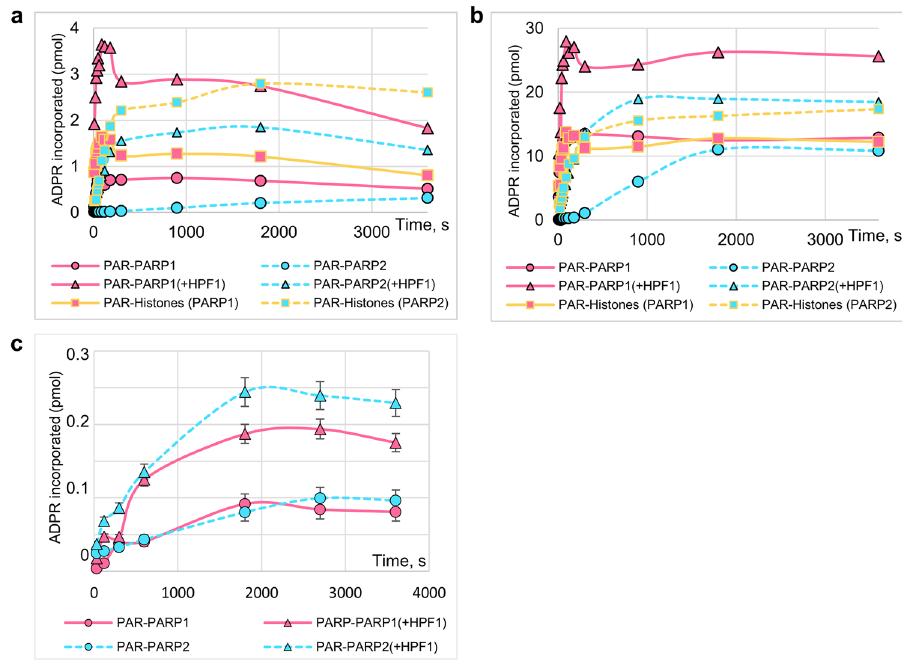
Fig. 4 HPF1 modulates the auto- and heteromodi fi cation activities of PARP1 and PARP2 at the initial stage of the reactions. Typical kinetic curves of PARP1- and PARP2-catalyzed reactions of ADP-ribose (ADPR) incorporation into PARPs and histones upon incubation of PARPs (500 nM) with [ 32 P]NAD + ( a, c 1 μ M; b 10 μ M) in the absence and presence of HPF1 ( a, b 1 μ M/0.5 μ M in PARP1/PARP2-catalyzed reactions; c 1 μ M), in the presence of 250 nM NCP ( a , b ) or its absence ( c ). Original autoradiograms are presented in Supplementary Fig.